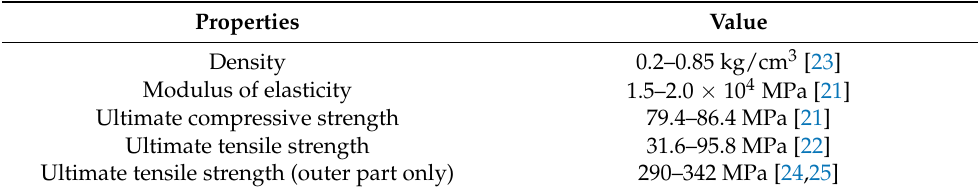
Table 1. Mechanical properties of bamboo materials as reported in the